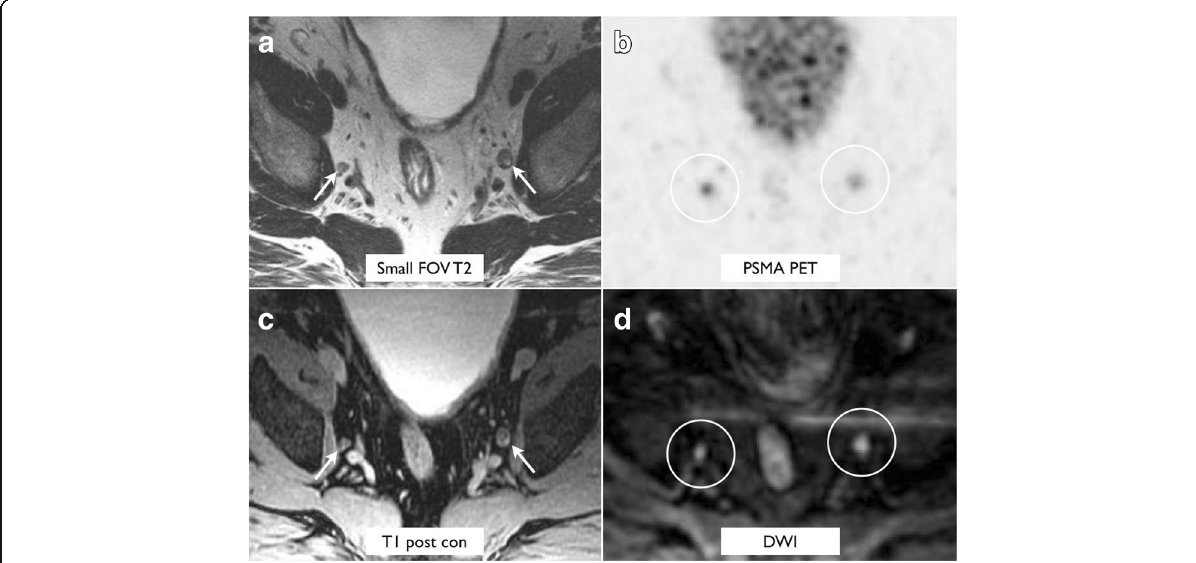
Fig. 2 A 67-year-old man with biochemical recurrence (PSA of 8.0), who had bilateral pelvic side wall lymph nodes measuring 0.7 and 1.0 cm seen on T2-weighted imaging ( a ), PSMA PET ( b ), post-gadolinium T1-weighted imaging ( c ), and DWI ( d